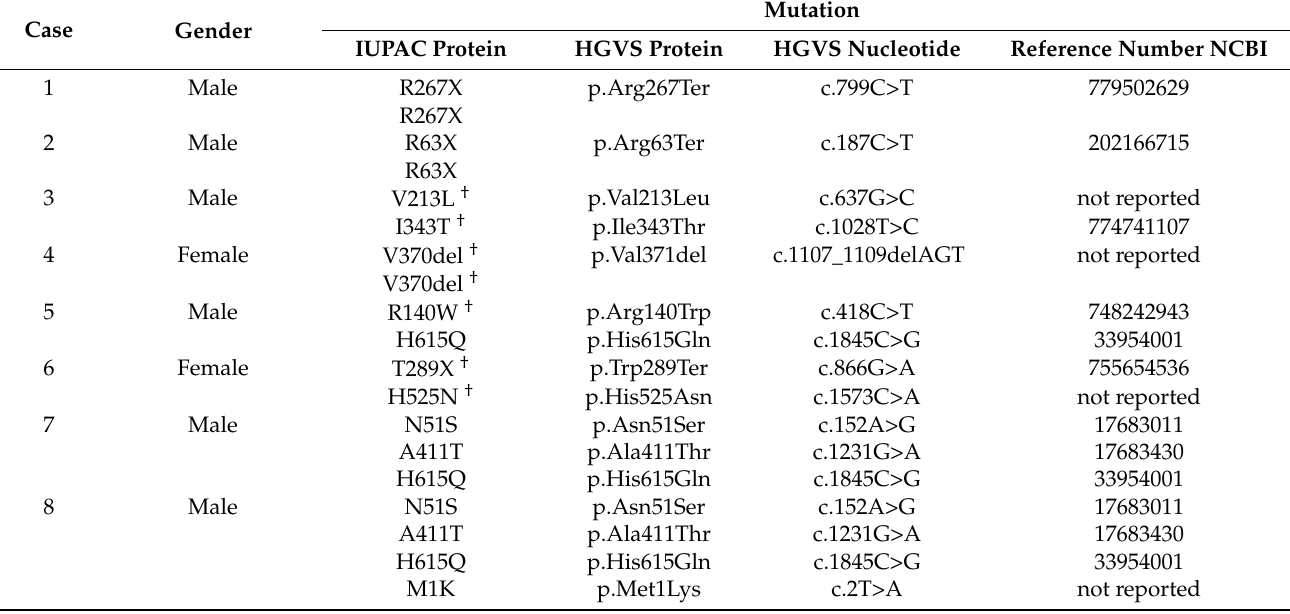
Table 5. Molecular analysis of patients with glucose-galactose malabsorption included in the present